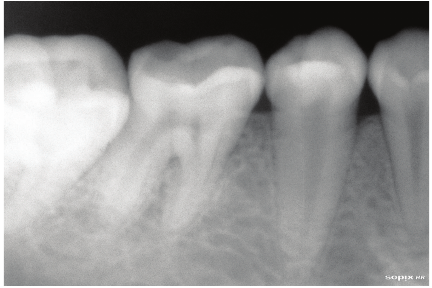
Figure 4: Short crown root length of mandibular I molar and premolar.